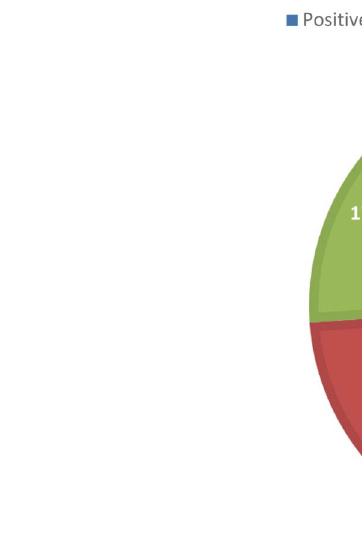
same (81 tokens) was used primarily neutrally (55 tokens) on the same day but could also signify negative polarity when tweets narrate that things are no longer the same for the mourning families (26